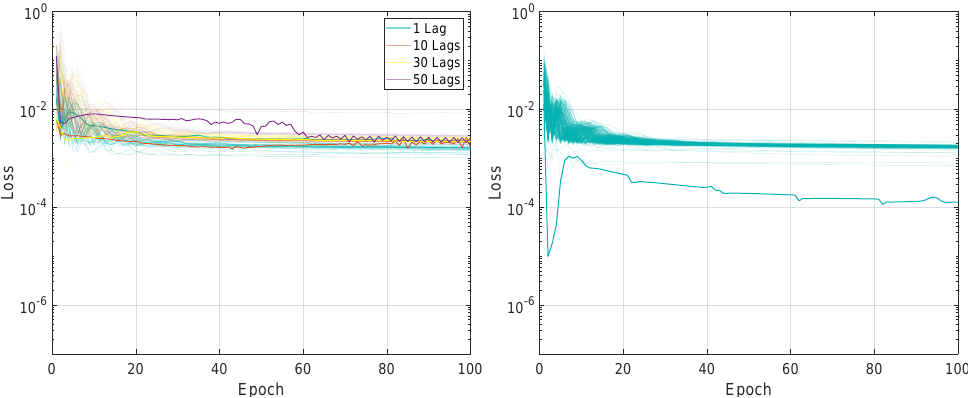
Figure 7. Illustration of the training loss for Experiment 2, LSTMTF ( left ) and VLSTM ( right ), using a many-to-one prediction mode. For each architecture, the lines with the same colors represent the loss for networks trained with the training mini-batch sizes in the [2:128] range. The highlighted thick lines represent the training loss for a mini-batch size of